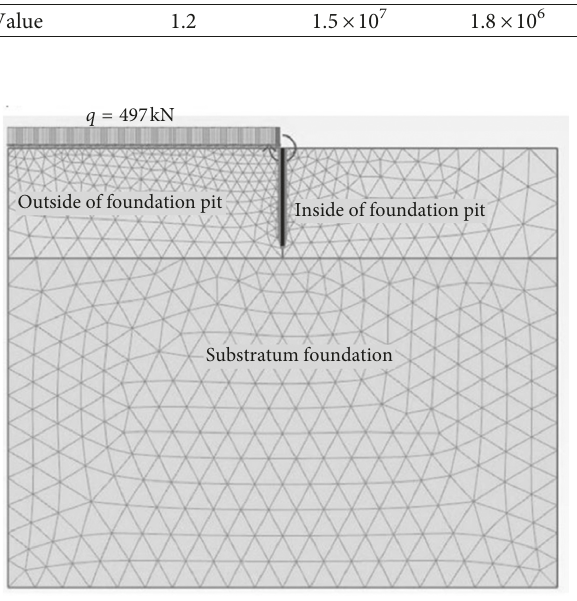
Figure 8: Basic finite element analysis